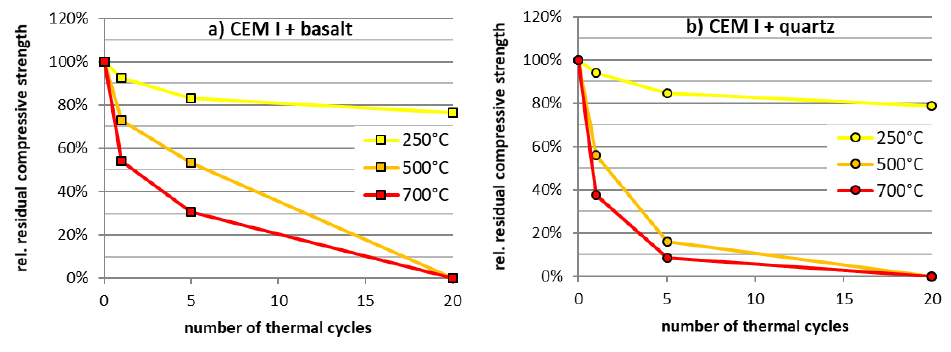
Figure 3. Residual compressive strength for concrete containing CEM I and basalt (a) and quartz (b).